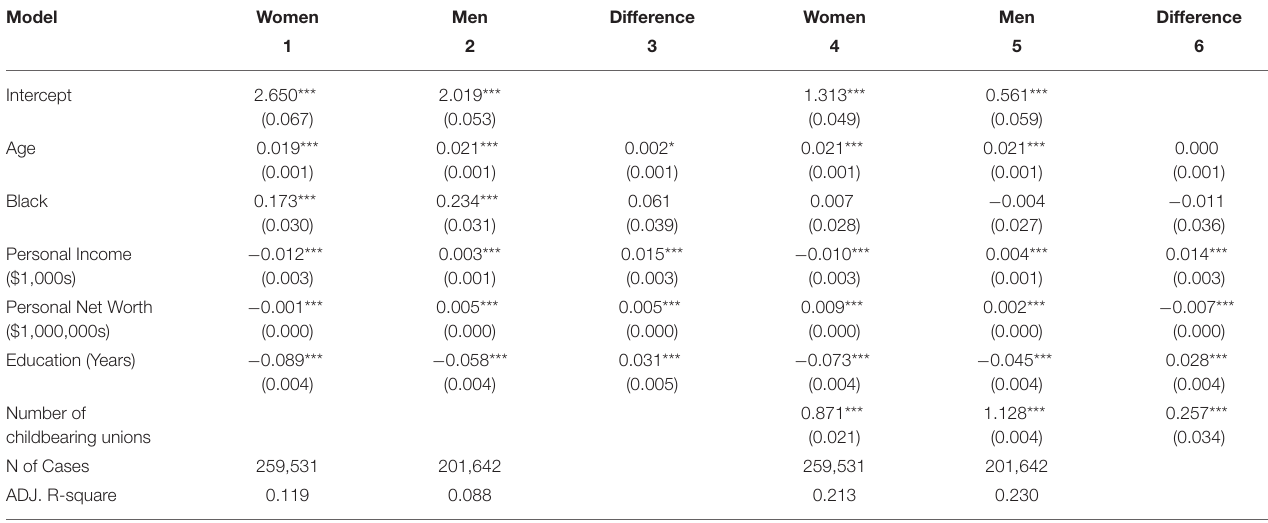
TABLE 4 | Total number of children ever born by income, net worth, education, and number of childbearing unions (only those with at least one childbearing partner). Model